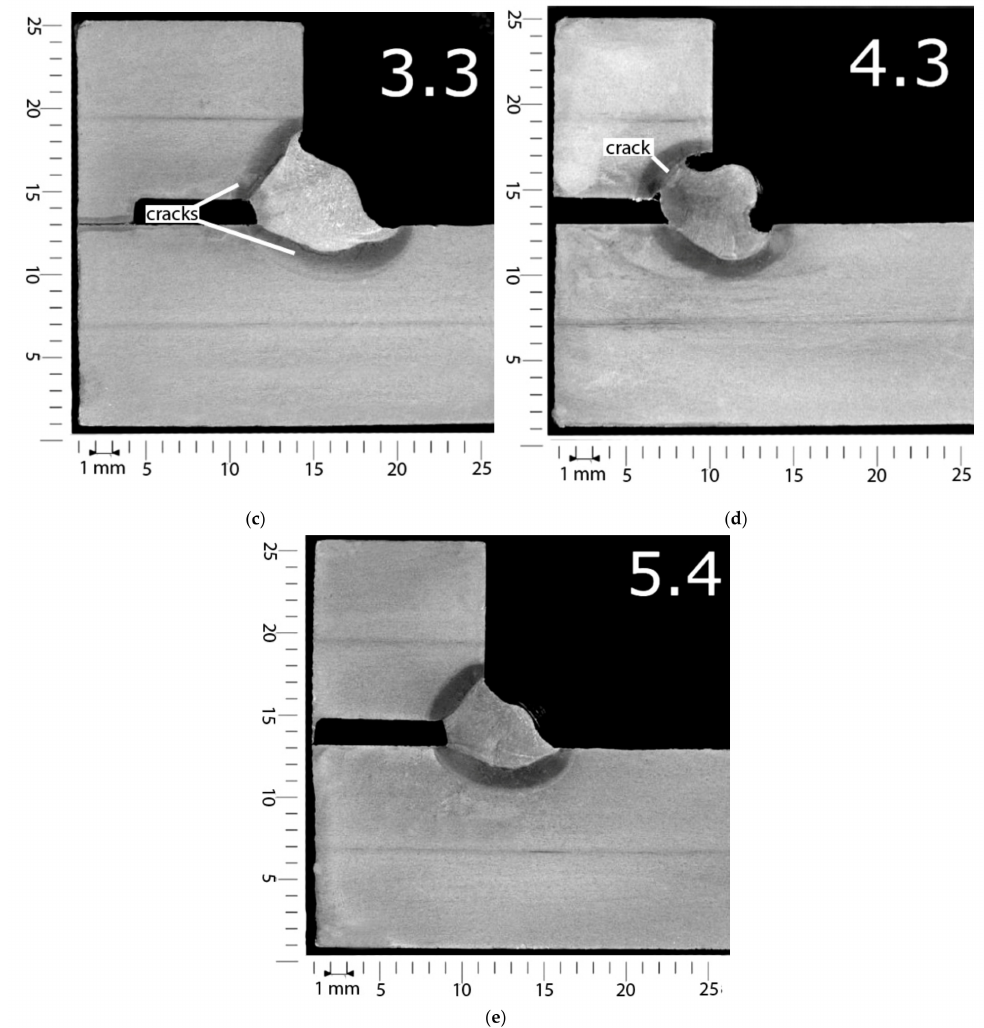
Figure 3. Exemplary results of macroscopic testing: ( a ) weld 1—specimen 1 (non-modified electrode), pores and undercuts; ( b ) weld 1—specimen 2 (underwater electrode), cracks in the heat-affected zone (HAZ); ( c ) weld 2—specimen 3 (concrete impregnate), cracks in the HAZ and undercuts; ( d ) weld 2—specimen 4 (liquid foil), cracks in the HAZ and deep undercuts; ( e ) weld 2—specimen 5 (paraffin wax), no